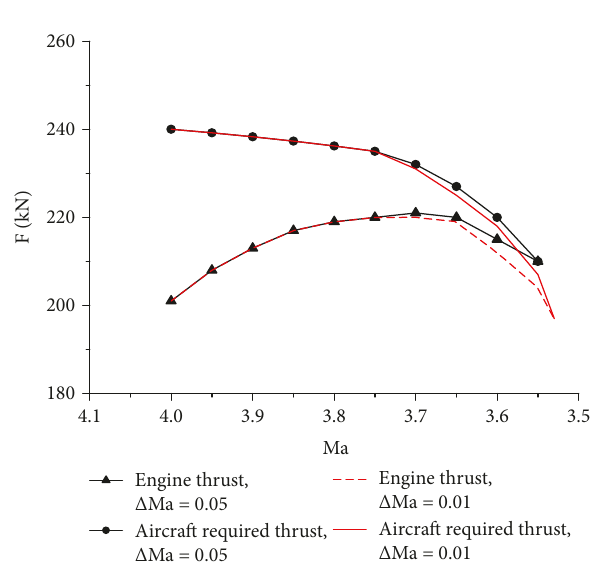
Figure 11: In fl uence of deceleration interval on Ma - F